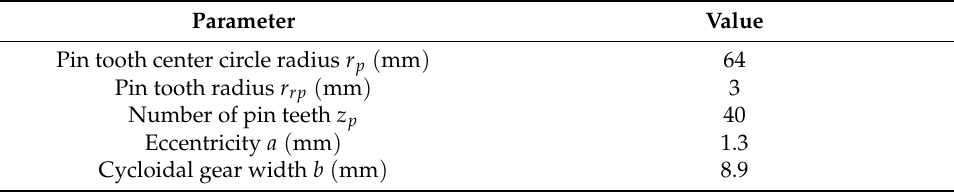
Figure 7. Schematic diagram of the conversion of the normal variation of the cycloidal gear profile. Table 2. Cycloidal gear design parameters.